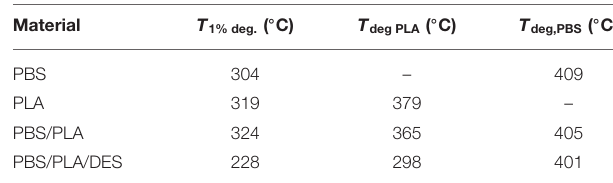
TABLE 3 | Degradation temperatures of poly(butylene succinate) (PBS) and poly(lactic acid) (PLA) phases and degradation temperature for 1% wt loss